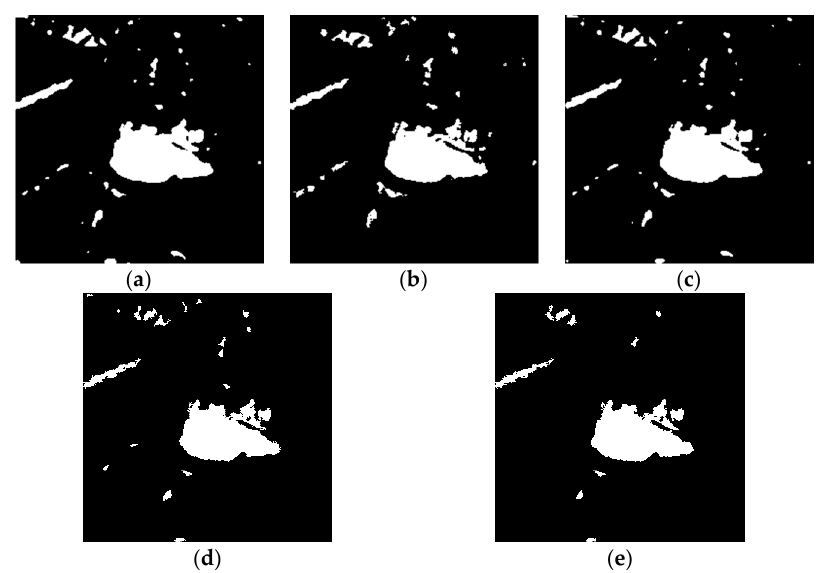
Figure 11. Change detection results generated by different methods on the San Francisco dataset. ( a ) Result by PCAKM. ( b ) Result by MRFFCM. ( c ) Result by GaborTLC. ( d ) Result by D_MRFFCM. ( e ) Result by the proposed method. Table 2. Change detection results of different methods on the San Francisco dataset.